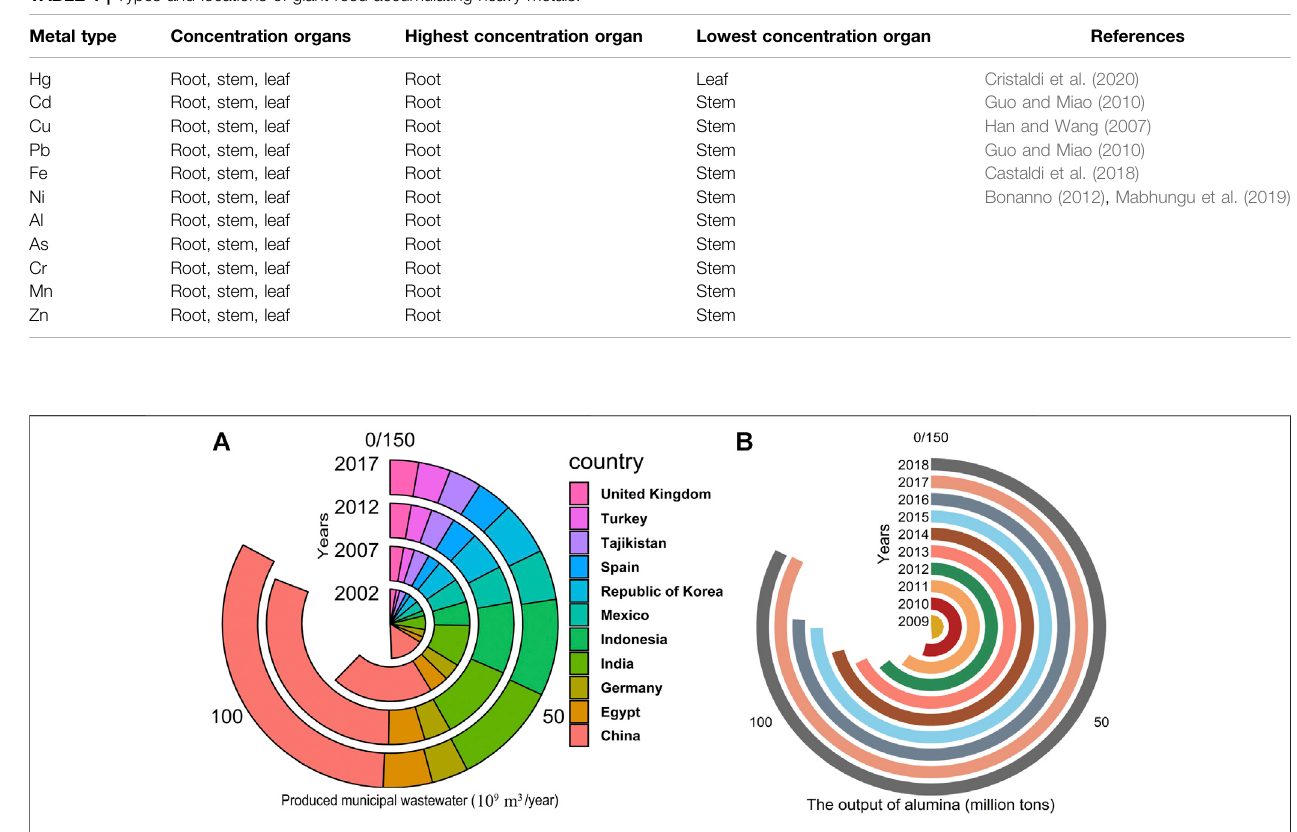
FIGURE 3 | Produced municipal wastewater in different countries (A) and the output of alumina in the world (3B) .